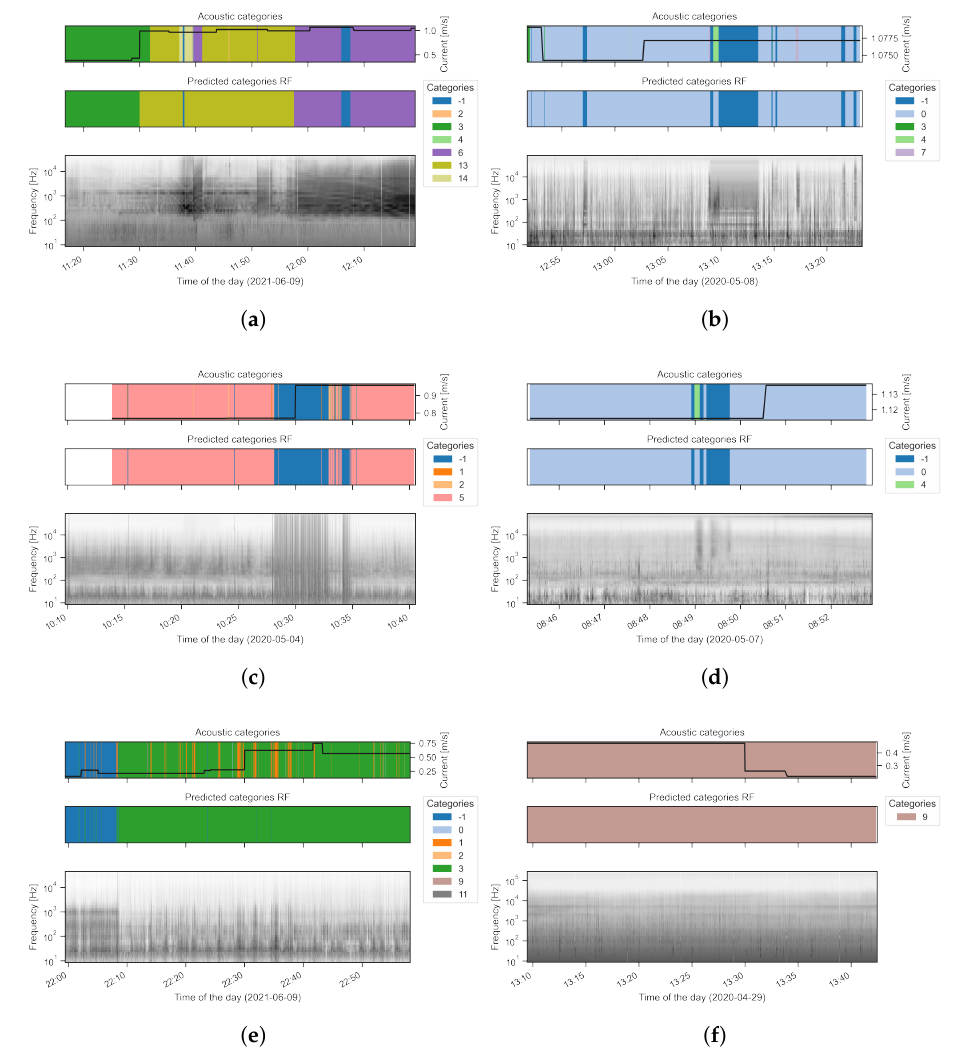
Figure A2. Examples of deployments evolution in time, recorded on the ( a ) 9 June 2021 ( b ) 8